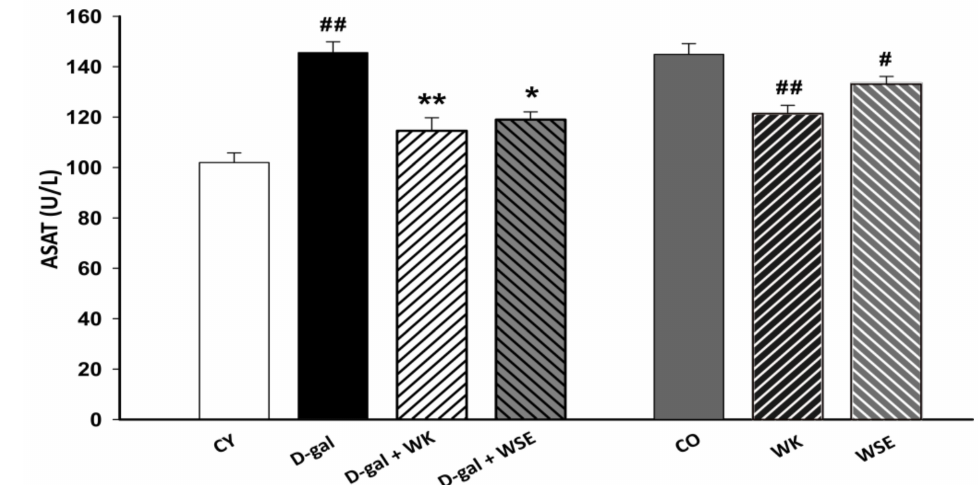
Figure 3. ASAT levels in D-gal-induced aging and naturally aged rats (values expressed as mean ± SD; n = 8); # p < 0.05 and ## p < 0.01 compared to CY or CO; * p < 0.05 and ** p < 0.01 compared to D-gal group (CO—control old; CY—control young; D-gal—D-galactose; WK—walnut kernel; WSE—walnut septum